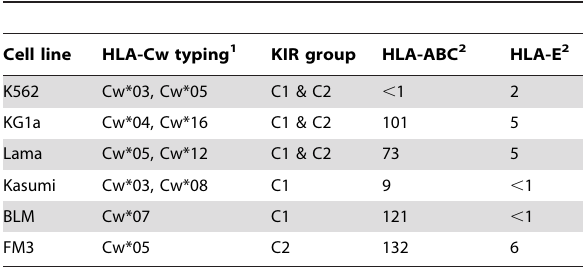
Table 1. HLA-C subtype, KIR group and cell surface expression of HLA molecules by the different target cell